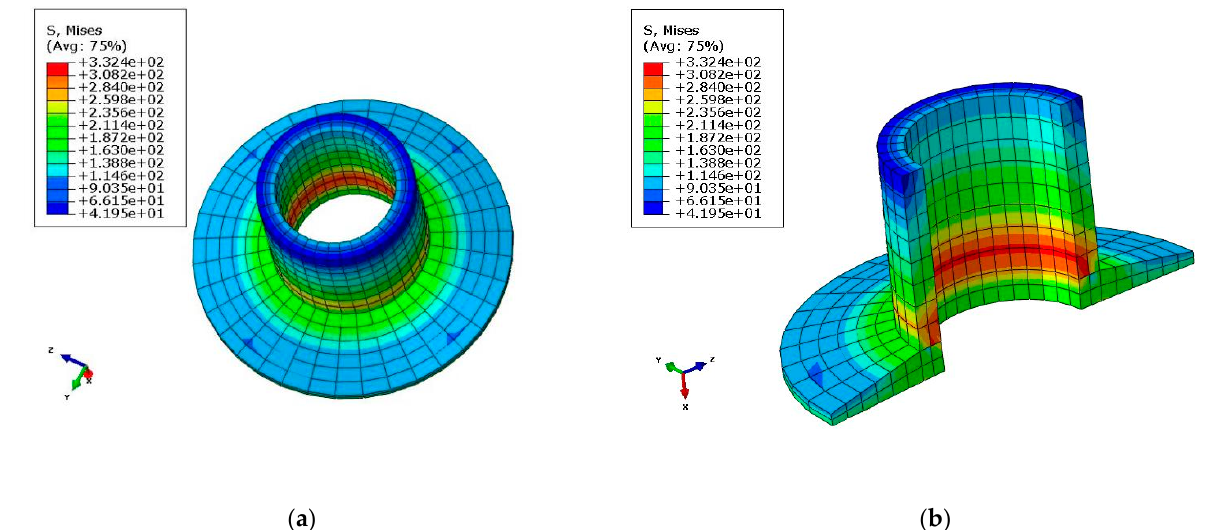
Figure 8. Von Mises stress of AL inserts ( σ y = 332.4 MPa): ( a ) Von Mises stress (overall view); ( b ) Von Mises stress (partial view).